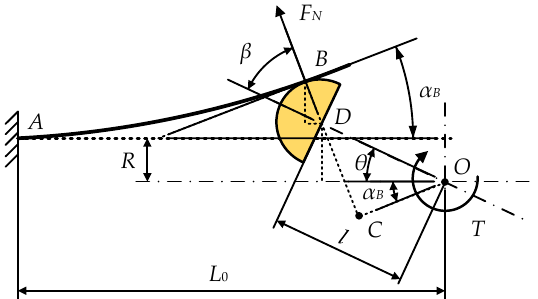
Figure 5. Loading analysis unit of the variable stiffness actuator.